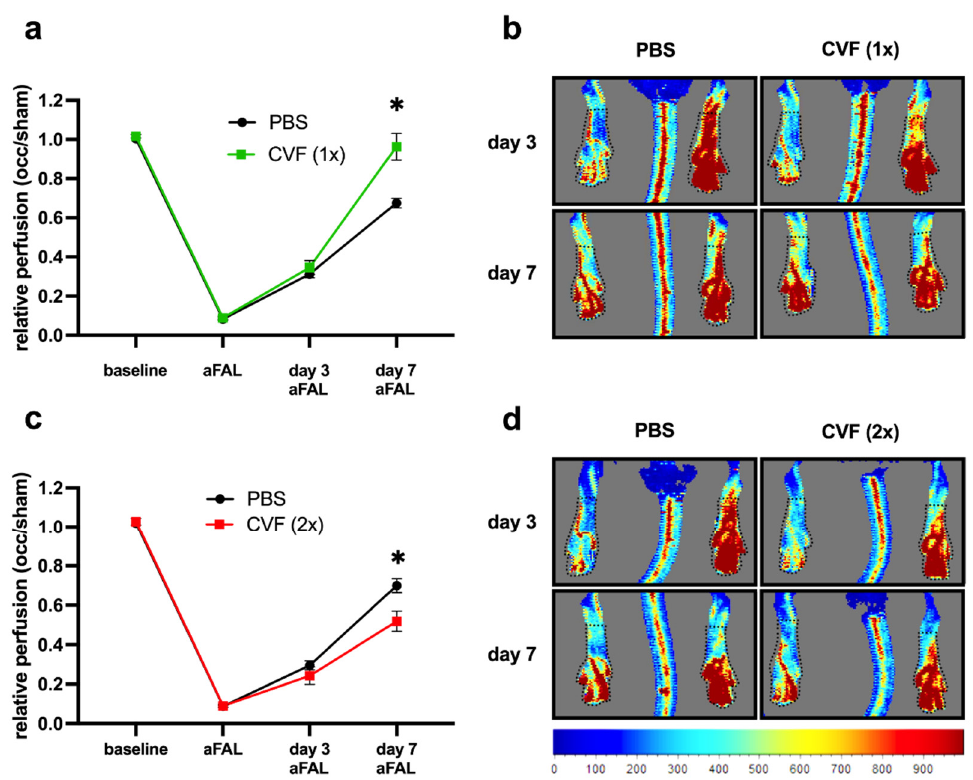
Figure 2. Impact of CVF administration on the perfusion after femoral artery ligation (FAL). ( a , b ) Single-dose application of the cobra venom factor (CVF (1x)) promotes perfusion recovery. ( a ) The line graph describes laser Doppler perfusion measurements of the hindlimbs from mice treated with a single dose of phosphate-buffered saline (PBS) or CVF (1x) 24 h prior to FAL. The relative perfusion was calculated using an occluded/sham (right to left hind limb) ratio before FAL (baseline), directly after FAL (aFAL), at day 3, and at day 7 aFAL. Data are the means ± S.E.M., n = 5 mice per group, * p < 0.05 (PBS vs. CVF (1x)) by two-way analysis of variance (ANOVA) with the Bonferroni multiple comparison test. ( b ) Representative flux images of laser Doppler measurements from mice treated with a single dose of PBS (left images) or CVF (1x) (right images) showing color-coded the relative perfusion of hind limbs at day 3 and 7 aFAL (blue color indicates low perfusion, and red color indicates high perfusion). Black dotted lines indicate the regions of interest (ROI), which were used for perfusion analyses. ( c , d ) Repeated treatment of mice with CVF (2x) counteracts the perfusion recovery. ( c ) The line graph depicts the results of the laser Doppler perfusion measurements of the hind limbs of repeated PBS- or CVF (2x)-treated mice. Some (12.5 µg CVF) were administered by i.p. injection 24 h prior FAL and again 3 days aFAL. The relative perfusion was calculated using the occluded/sham (right to left hind limb) ratio before FAL (baseline), directly aFAL, at day 3, and at day 7 aFAL. Data are the means ± S.E.M., n = 5 per group, * p < 0.05 (PBS vs. CVF (2x)) by two-way analysis of variance (ANOVA) with the Bonferroni multiple comparison test. ( d ) Representative flux images of laser Doppler measurements from repeated PBS- (left images) or CVF (2x)-treated mice (right images) showing in color code the relative hindlimb perfusion at day 3 and 7 aFAL. Black dotted lines indicate the ROI, which were used for perfusion analyses.